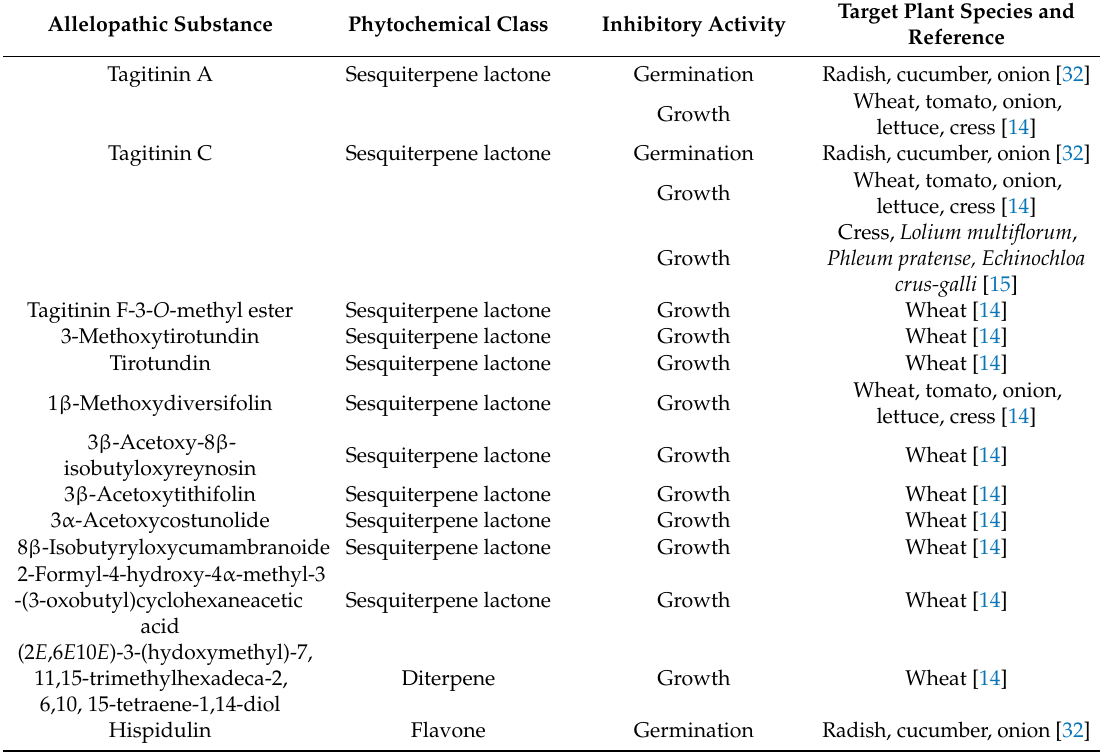
Table 2. Allelopatic substances found in T. diversifolia and target plant species for their activity. Allelopathic